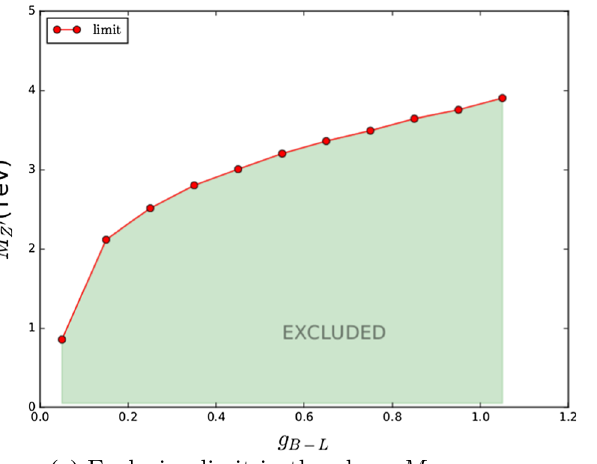
( a ) Exclusion limit in the plane M Z (cid:2) − g B − L (b) Exclusion limit in the plane M Z (cid:2) /g B − L − Fig. 8 LHC exclusion limits for the U ( 1 ) B − L model